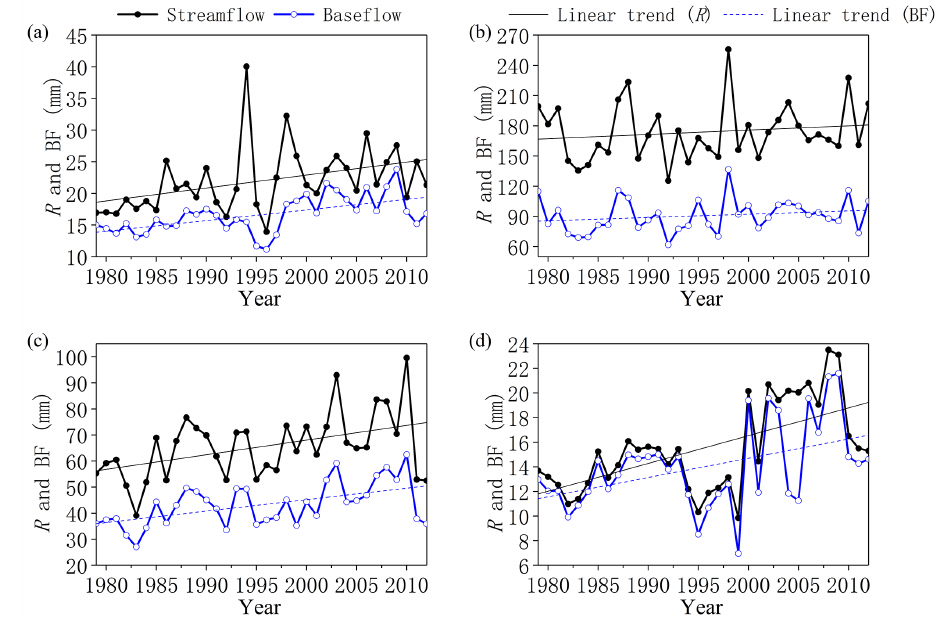
Figure 6. Variations in seasonal streamflow and baseflow in (a) spring, (b) summer, (c) fall and (d) winter from 1979 to 2013.